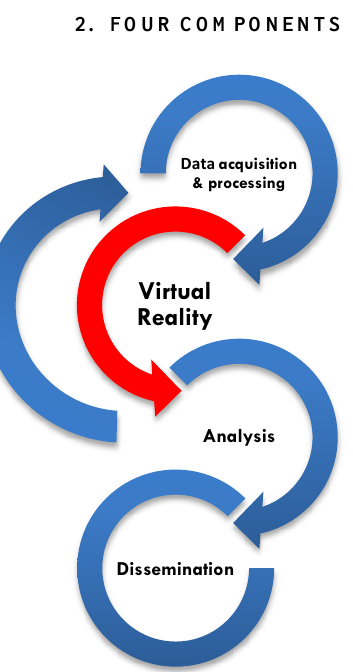
Figure 1. Four components of digital archaeology